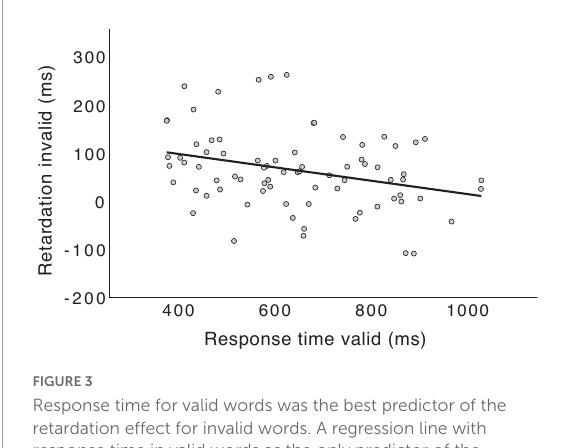
FIGURE2 Retardation effect. Suffixes in words with invalid combinations of word accent and suffix had longer response times than suffixes in words with valid combinations, t (79) = 5.93, p < 0.001.